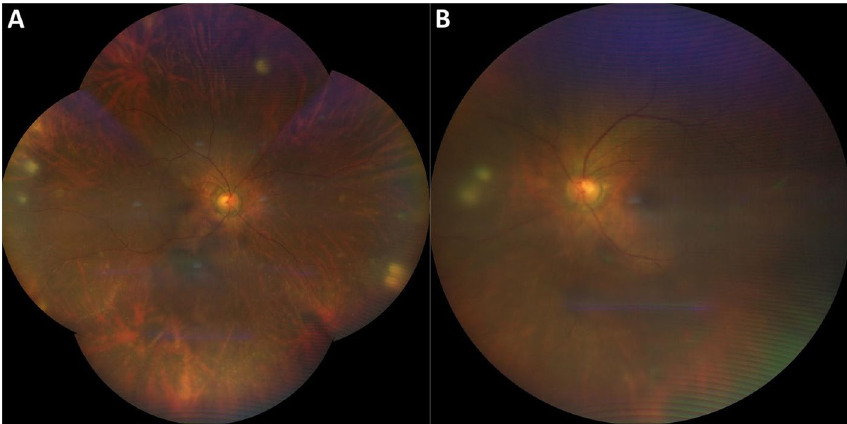
Fig. 2 Color fundus photographs of the right ( A ) and left ( B ) eye showing multiple round choroiditis